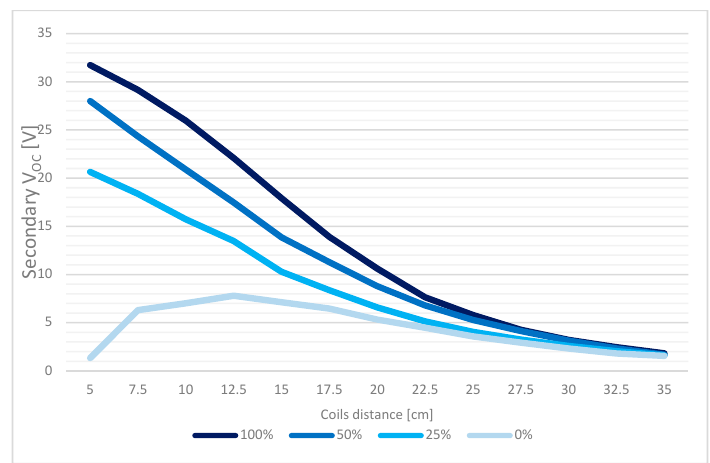
Figure 12. Inductive charging system characterization, free air and 12 V supply: secondary V OC in the coil displacement test. Coil distance is in Y direction of Figure 10a; displacement is expressed in percentage values as the X direction of Figure 10b.